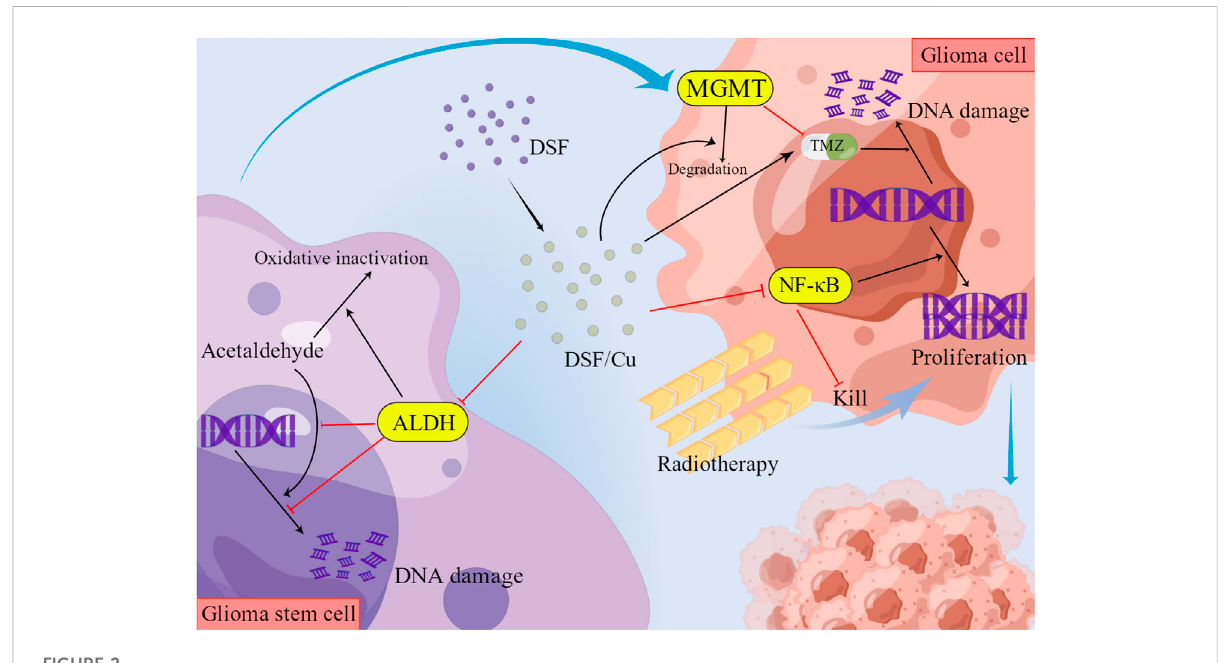
FIGURE 2 Molecular mechanisms of